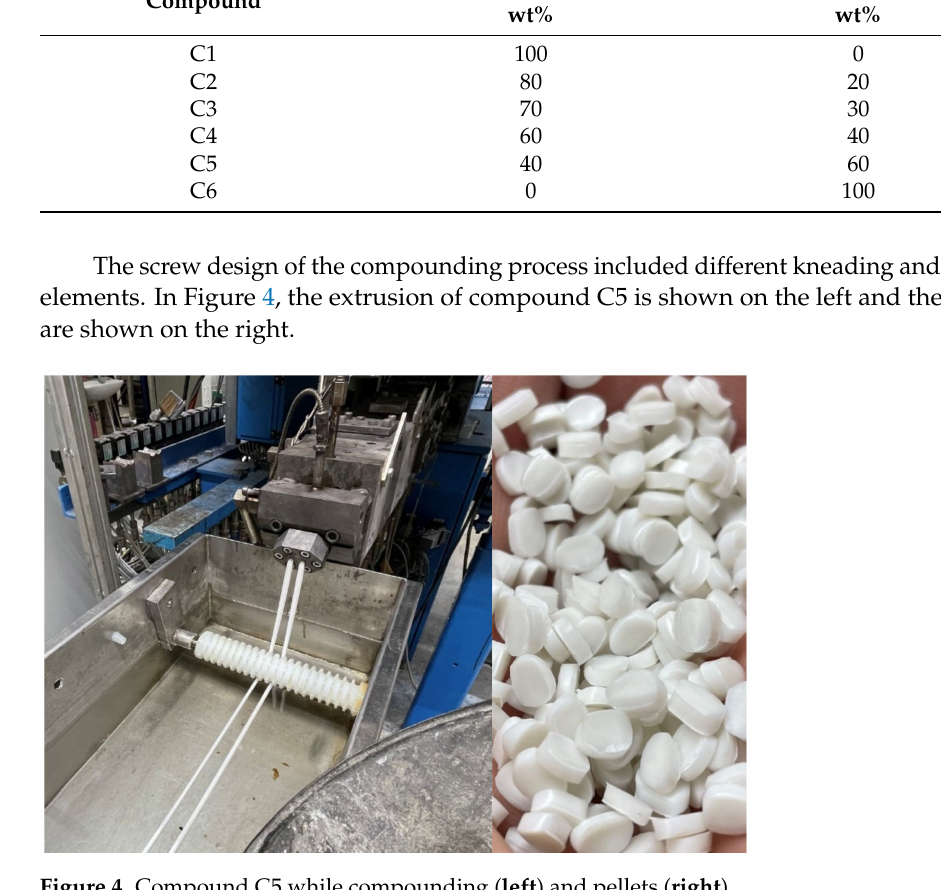
Figure 4. Compound C5 while compounding ( left ) and pellets ( right